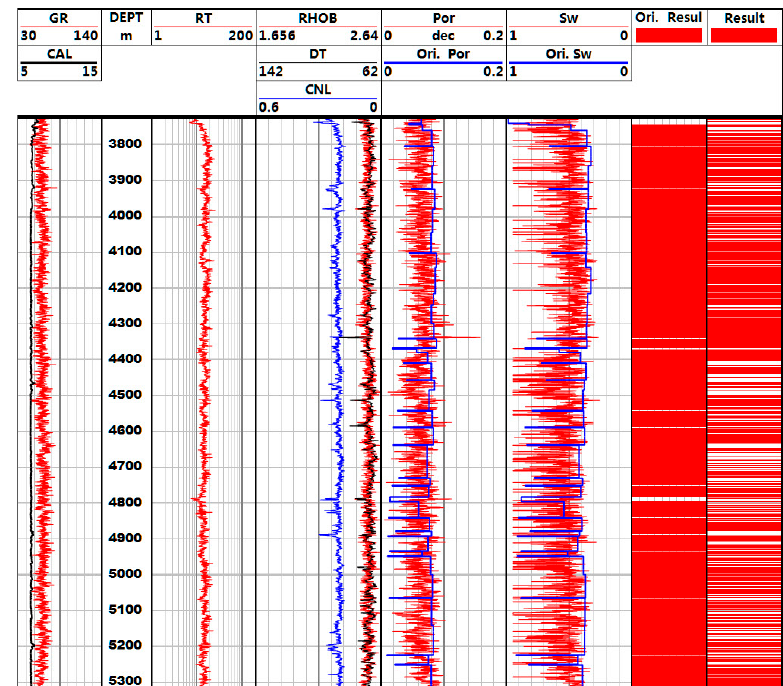
Figure 14. The logging interpretation result for Well XX21012.